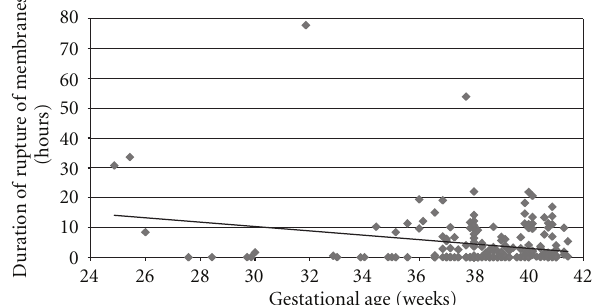
Figure 1: Gestational age and median lengths of time of